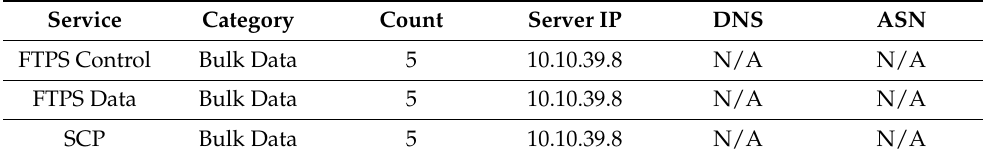
Table 10. Bulk data category IP/ASN query